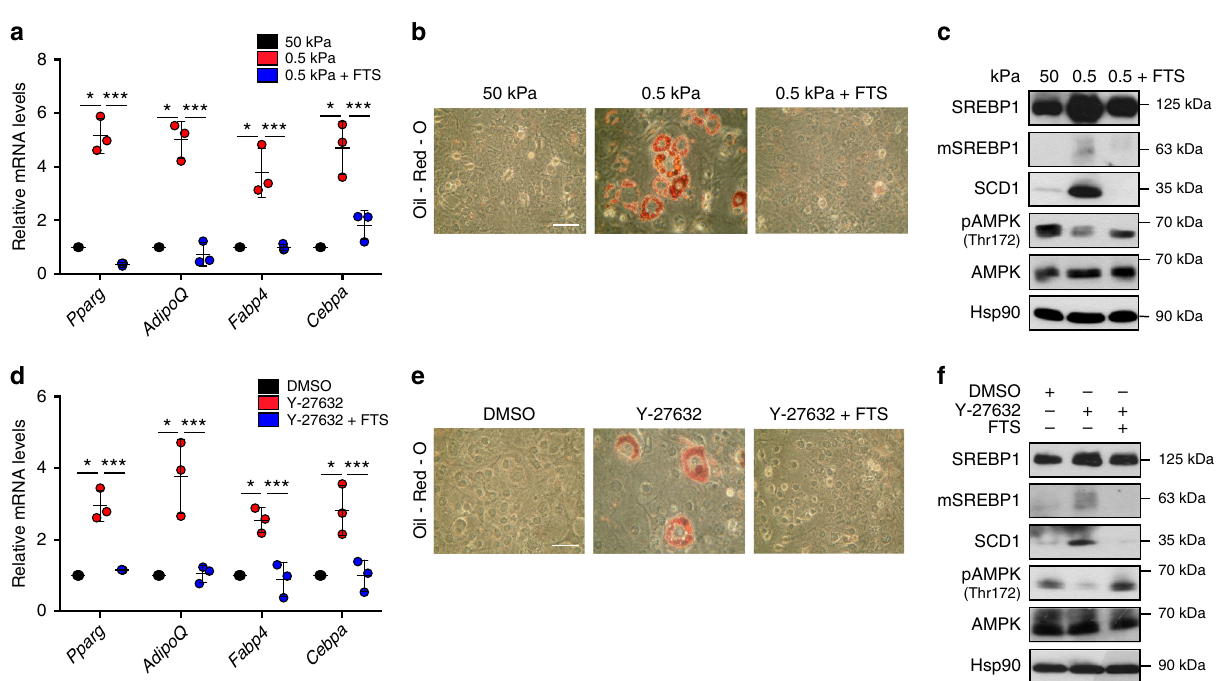
Fig. 5 SREBP1 regulates mesenchymal stem cell commitment upon cytoskeleton remodelling. a RT-qPCR quanti fi cation of the indicated genes in mouse mesenchymal stem cells (mMSCs) cultured on stiff (50 kPa elastic modulus, as control) or soft (0.5 kPa elastic modulus) fi bronectin-coated hydrogel matrix, or soft (0.5 kPa elastic modulus) fi bronectin-coated hydrogel matrix with fatostatin treatment (FTS). Values are expressed as mRNA levels